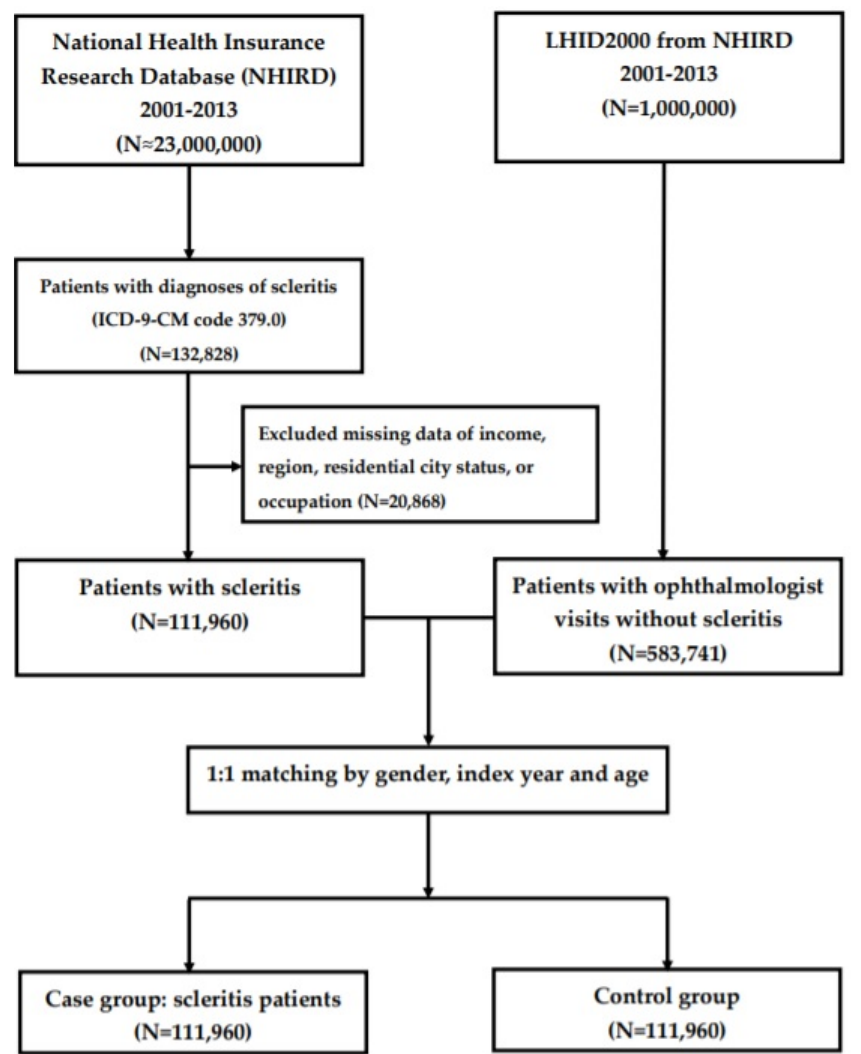
Figure 1. Flowchart demonstrating the enrolment of patients with scleritis and the control patients.